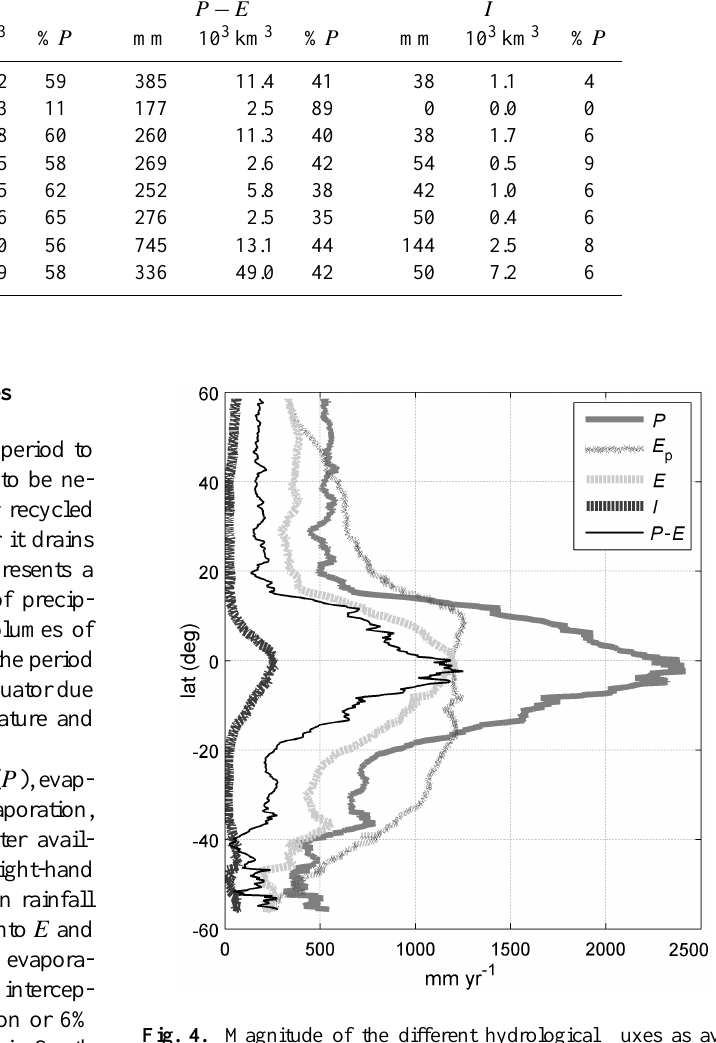
Fig. 4. Magnitude of the different hydrological fluxes as aver- age along the latitudinal bands (modified from Fisher et al., 2008). The results correspond to the application of GLEAM for the period 2003–2007. E p refers to potential